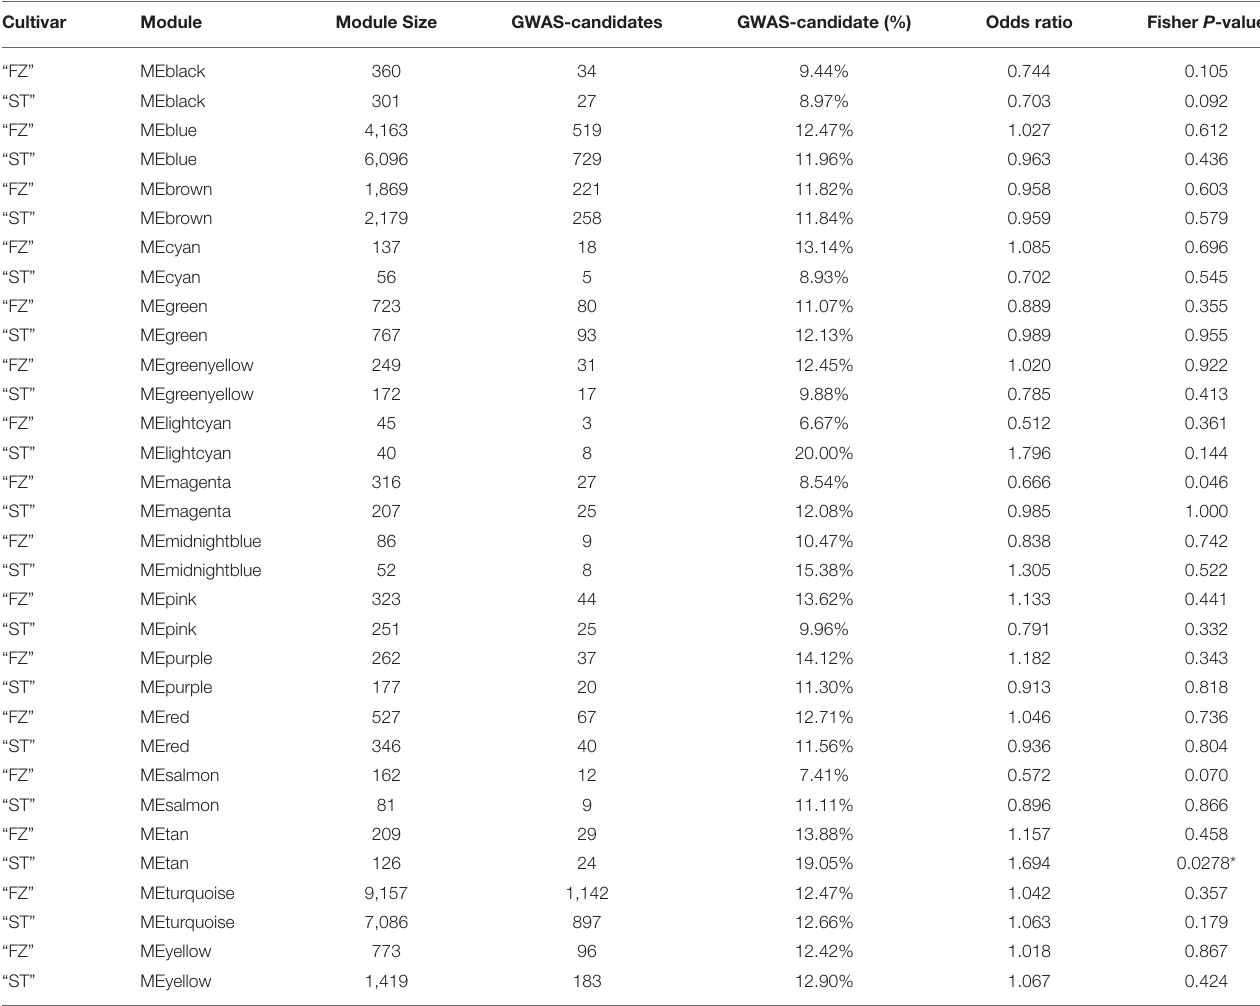
TABLE 2 | The number of genome-wide association study (GWAS) candidates within the modules identified from co-expression network analyses for Prunus mume cultivar “Fenhongzhusha” (“FZ”) and “Subaitaige” (“ST”). Cultivar